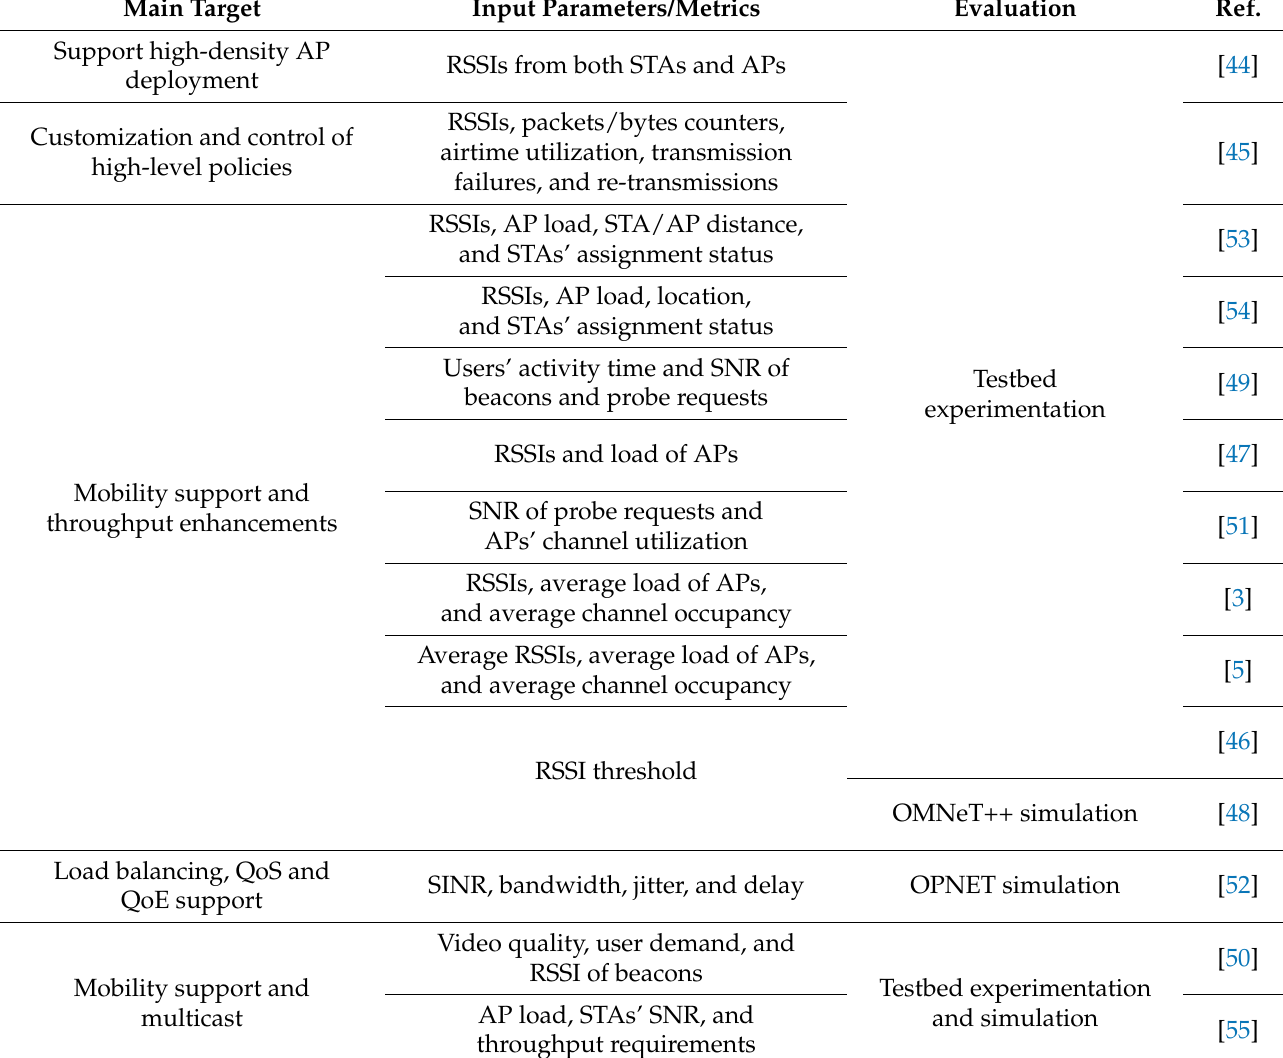
Table 2. Summary of the main centralized-horizontal user association and load balancing solutions in Software-Defined Networking (SDN)-based IEEE 802.11